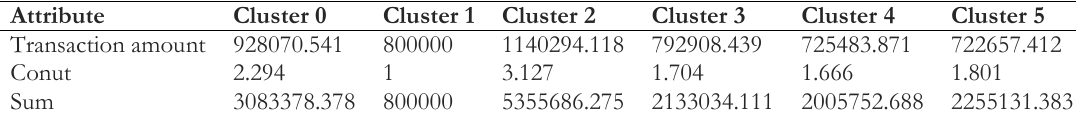
Table 2. The concentration of suspicious cases in the bile ducts.